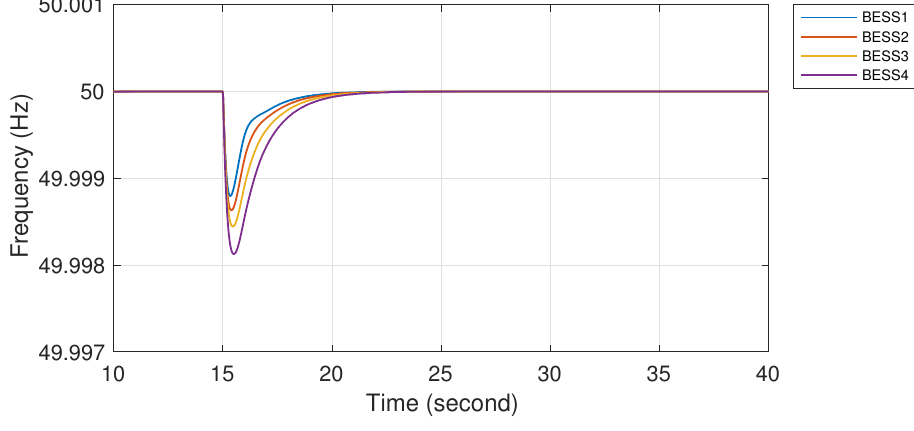
Figure 15. BESSs’ frequencies.